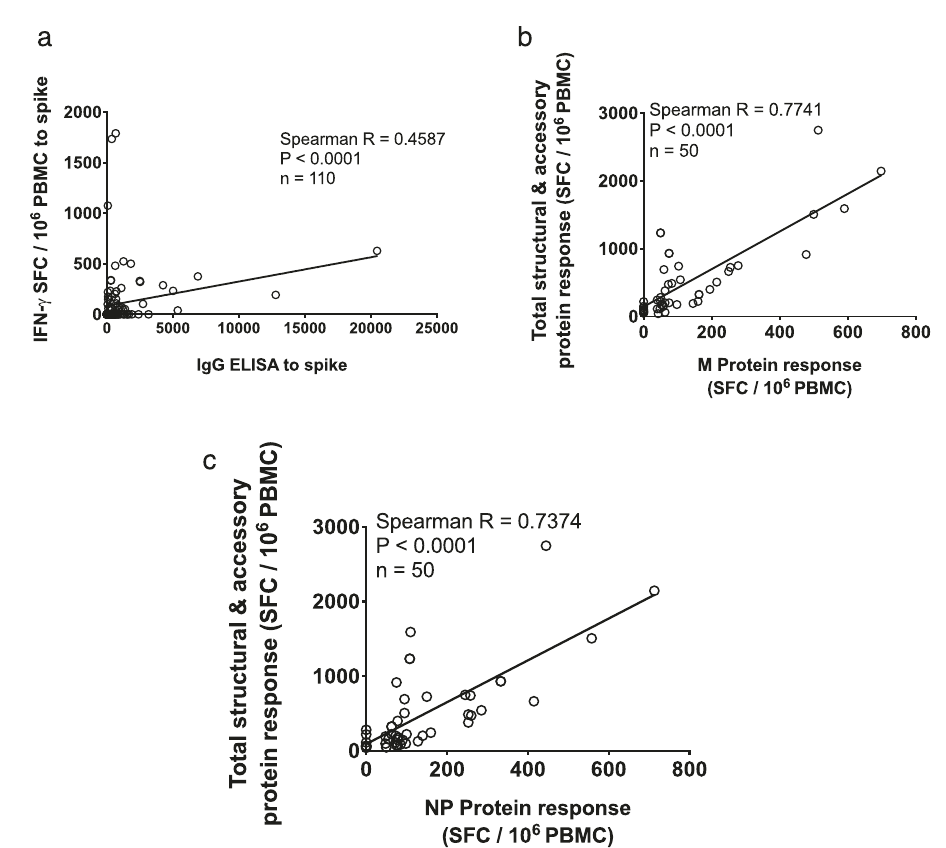
Fig. 2 Correlation between antibody and total summed ex vivo ELISpot responses. a Correlation between IgG ELISA to spike and ex vivo IFN- γ ELISpot summed response to spike ( n = 110), the correlation between ex vivo IFN- γ ELISpot response to b M protein and c NP and total summed response to spike, E, M, N, ORF 3, ORF6, ORF7 and ORF8 ( n = 50), SFC/10 6 PBMC = spot-forming cells per million peripheral blood mononuclear cells, with background subtracted. The correlation was performed via Spearman ’ s rank correlation coef fi cient and comparison of two groups by two-tailed Mann – Whitney U